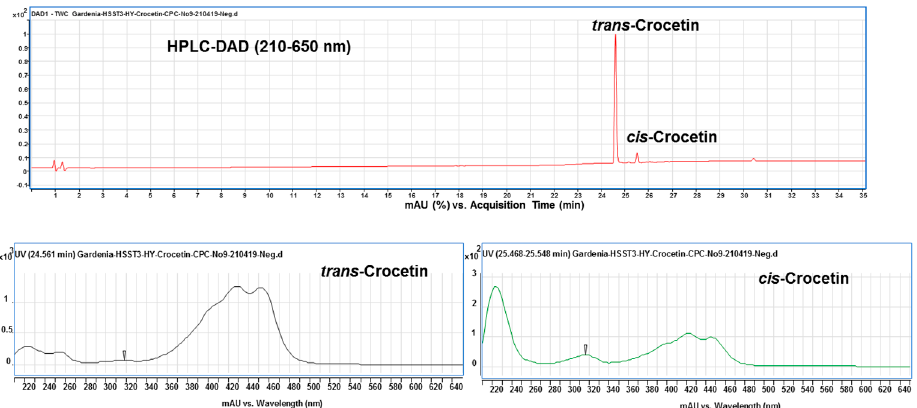
Figure 7. HPLC chromatogram (top panel) and UV-Vis spectrum (bottom panel) of trans - and cis - crocetin obtained from the CPC purification. Cis -crocetin showed a significant absorption peak at 316 nm different from that of trans -crocetin without the wavelength absorption.